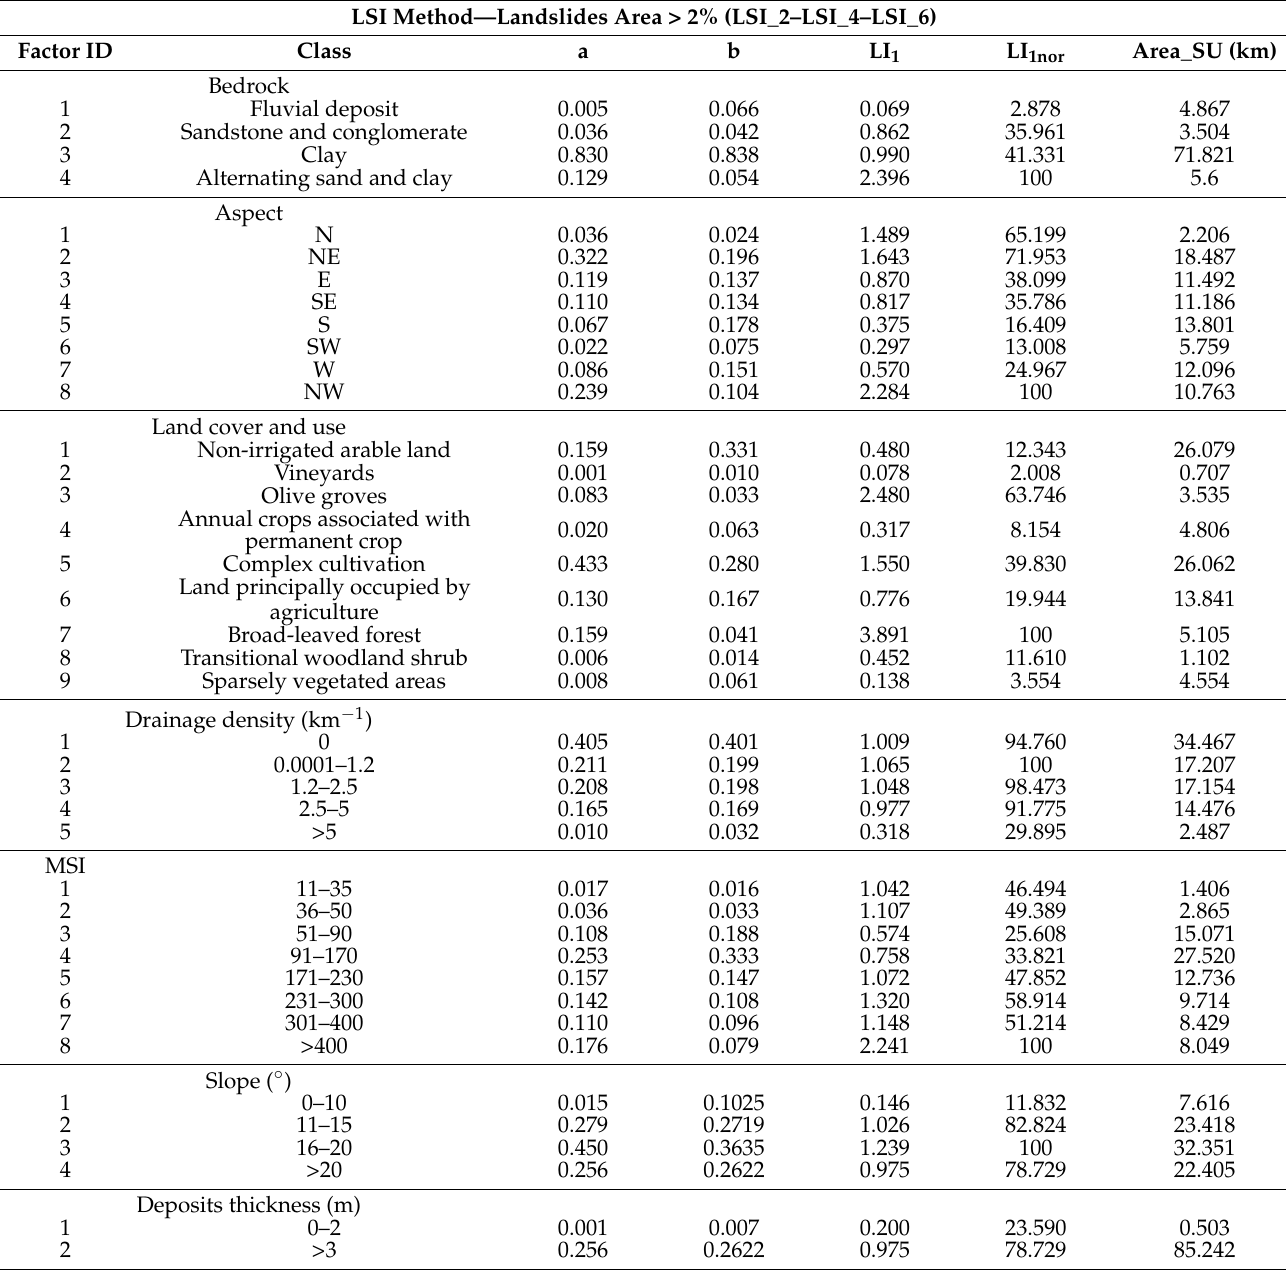
Table A3. Values of the parameters for deriving the LSI for the models